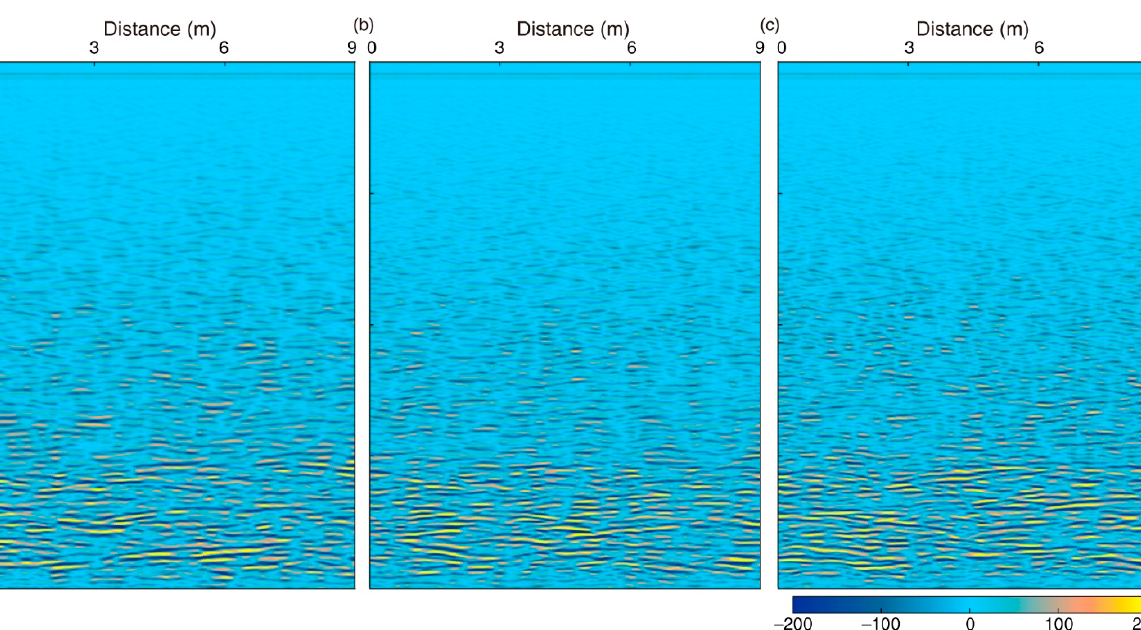
Figure 3. The simulated LPR profiles of the three models shown in Figure 2. ( a ) Gaussian ACF random media; ( b ) exponential ACF random media; ( c ) Von Kármán ACF media. The color bar represents intensity (arbitrary units).